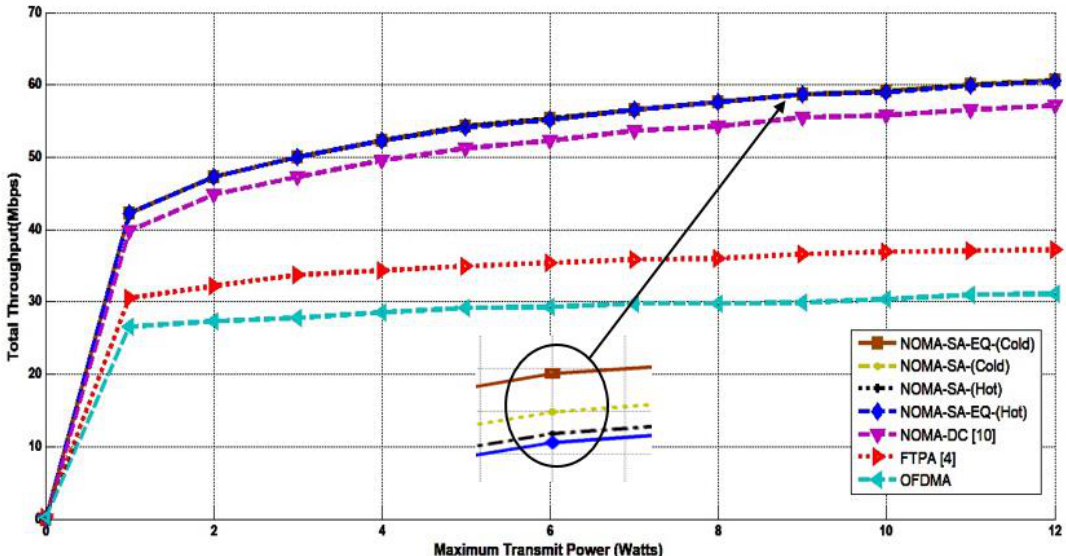
Figure 3. System’s Throughput Versus Maximum Transmit Power 12 Watt for 10 Users.